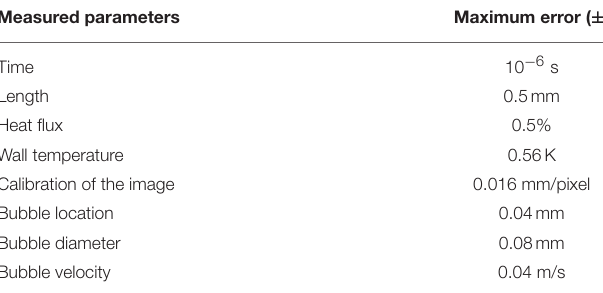
TABLE 2 | Estimated errors of main measurement